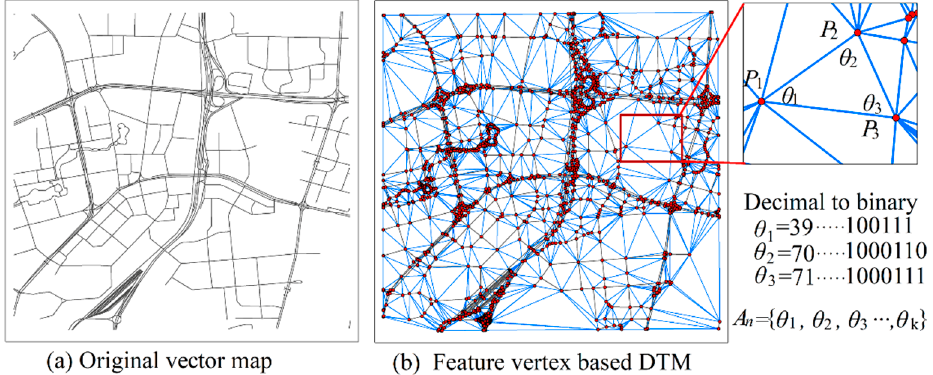
Figure 1. Construction of Delaunay triangulation mesh based on feature vertices. DTM: Delaunay Triangulation Mesh.